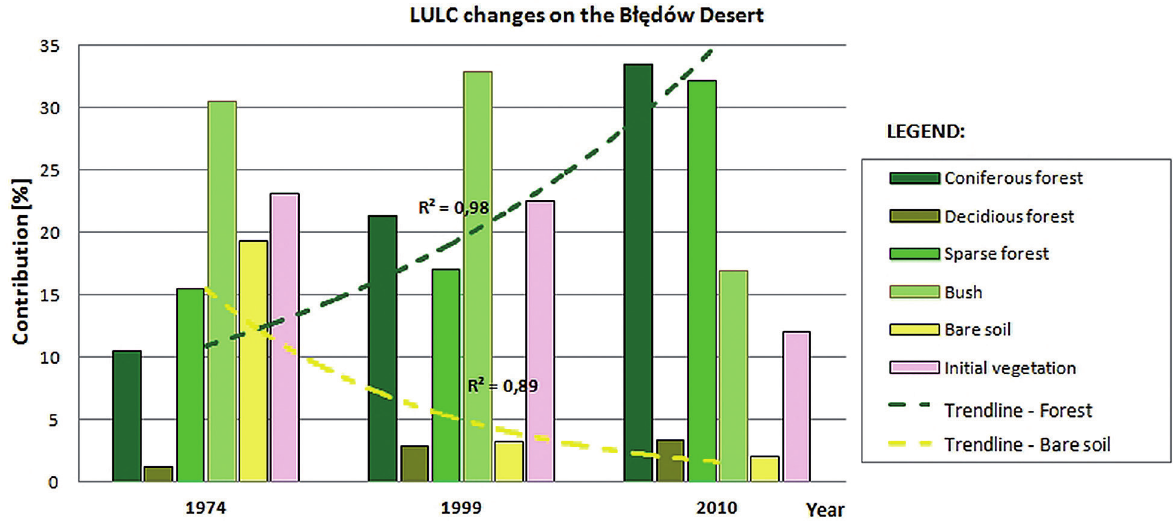
Fig. 4. LULC changes on the Błędów Desert – trend